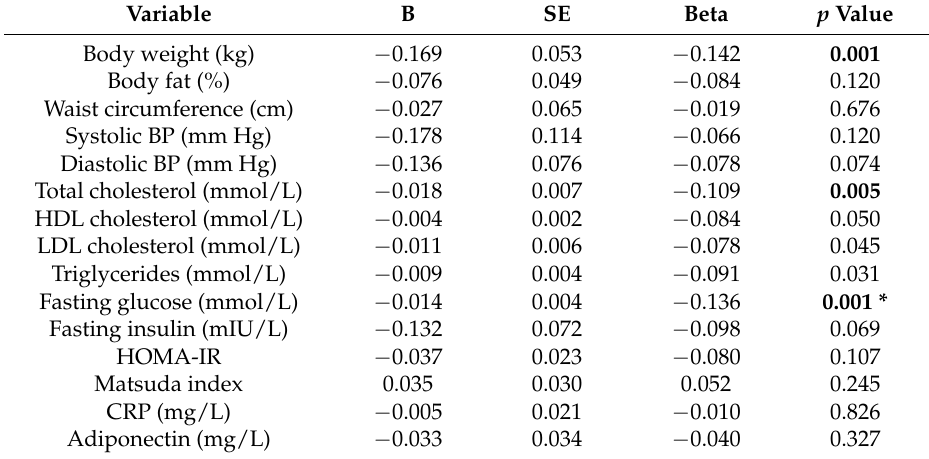
Table 3. Regression coefficients (B), their standard error (SE) and the standardized regression coefficients (Beta) for the associations between changes in anthropometric variables, blood pressure and metabolic factors during the weight maintenance phase and total protein intake (% of energy intake) 1 .